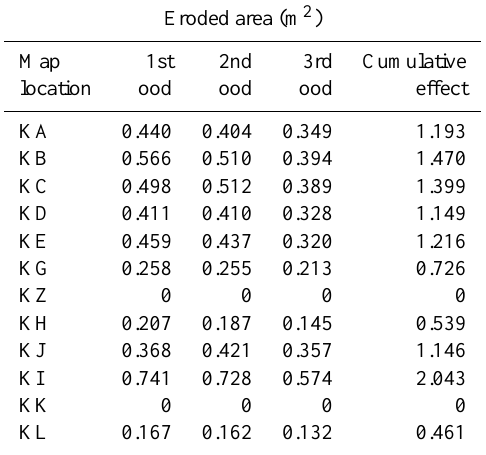
Table 1. Amount of bank erosion at the measurement locations (Fig. 1). Modelling results obtained by BSTEM.